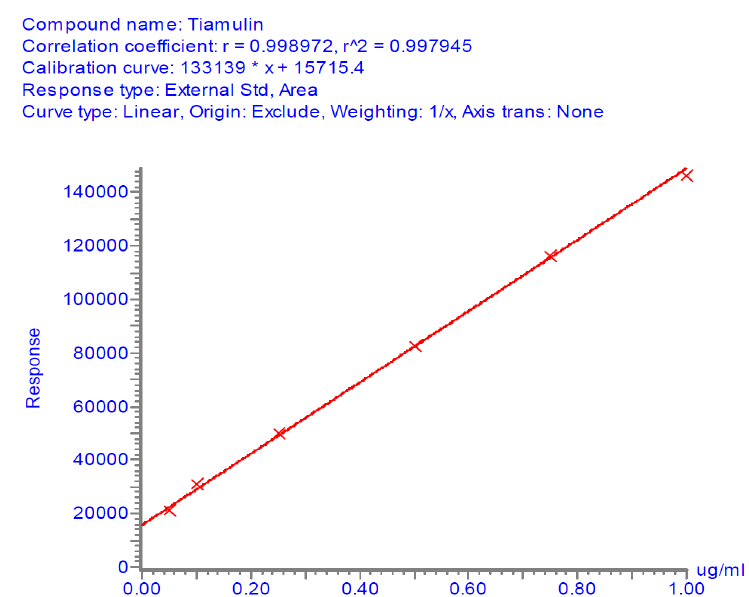
Figure A4. Chromatogram of the reference solution with a concentration of 0.5 μ g tiamulin/mL in the matrix.